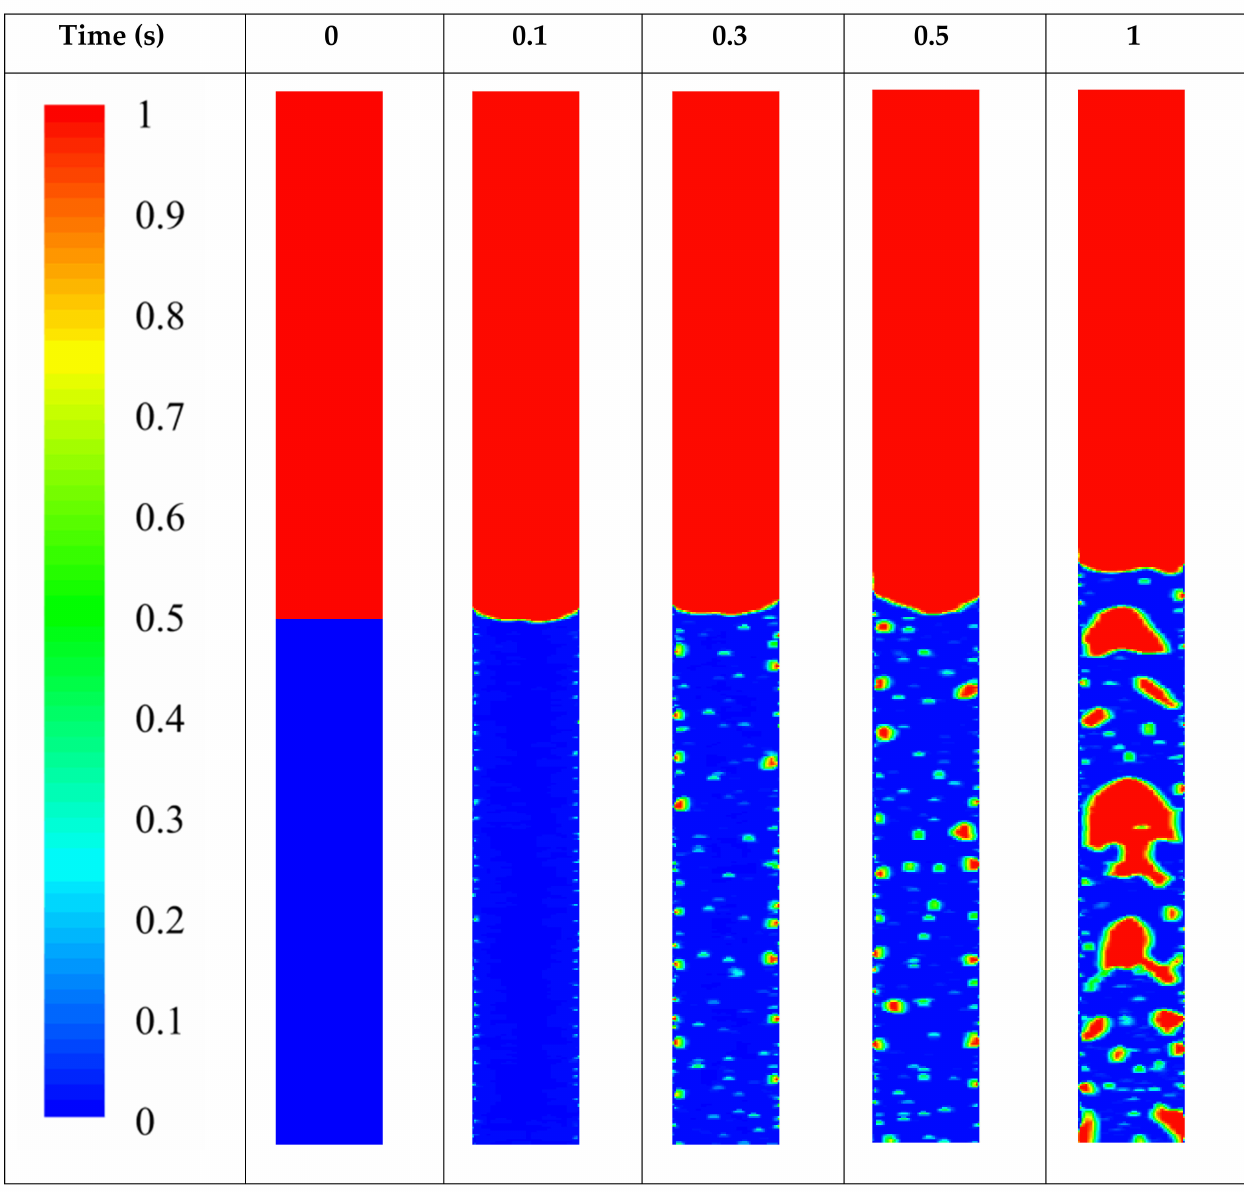
Figure 2. Contours of volume fraction in the evaporator part of TPCT charged by distilled water at different times for